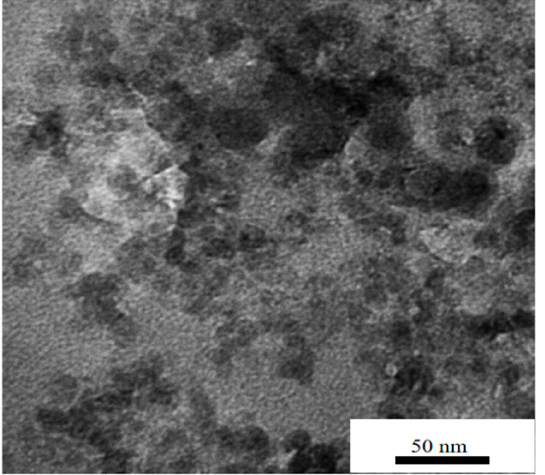
Figure 3. TEM morphologies of PI/nano-SiO 2 three-layer composite films doped with 5 wt%.